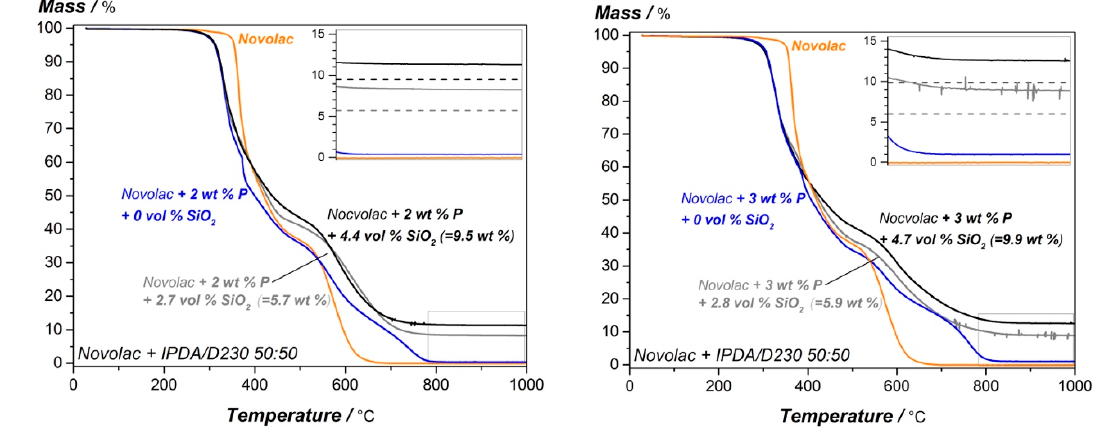
Figure 9. TGA mass loss curve for the modified epoxy novolac resin systems. Influence of silica content on 2 wt.% (left) and 3 wt.% (right) phosphorous modified resin. Table 6. T d5% , residual mass @700 ◦ C and @900 ◦ C from TGA curves and deviation according to Equation